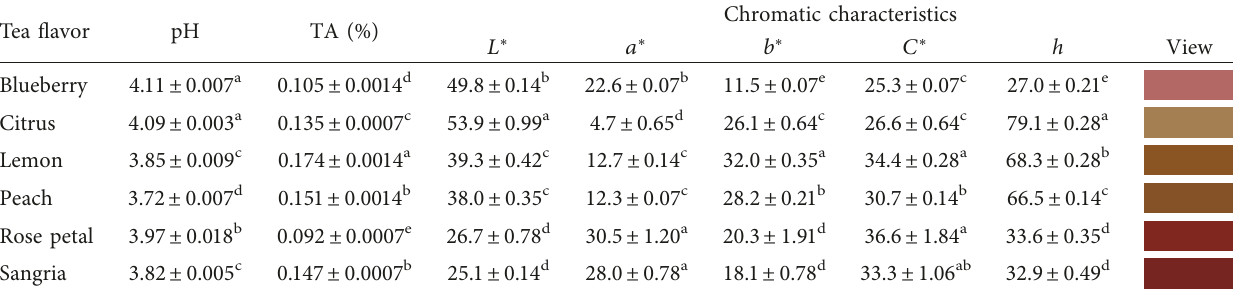
Values with different letters within same evaluation are significantly different ( p < 0 . 05, n � 3). Table 3: Mineral composition of ready-to-drink flavored-colored commercial teas. Tea flavor